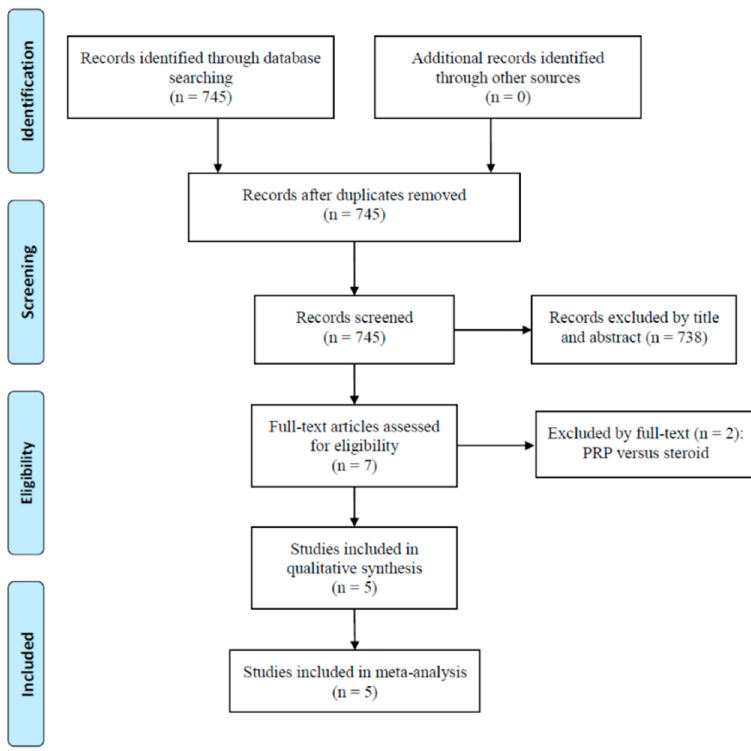
Figure 1. A flow diagram of study inclusions. PRP, platelet-rich plasma.